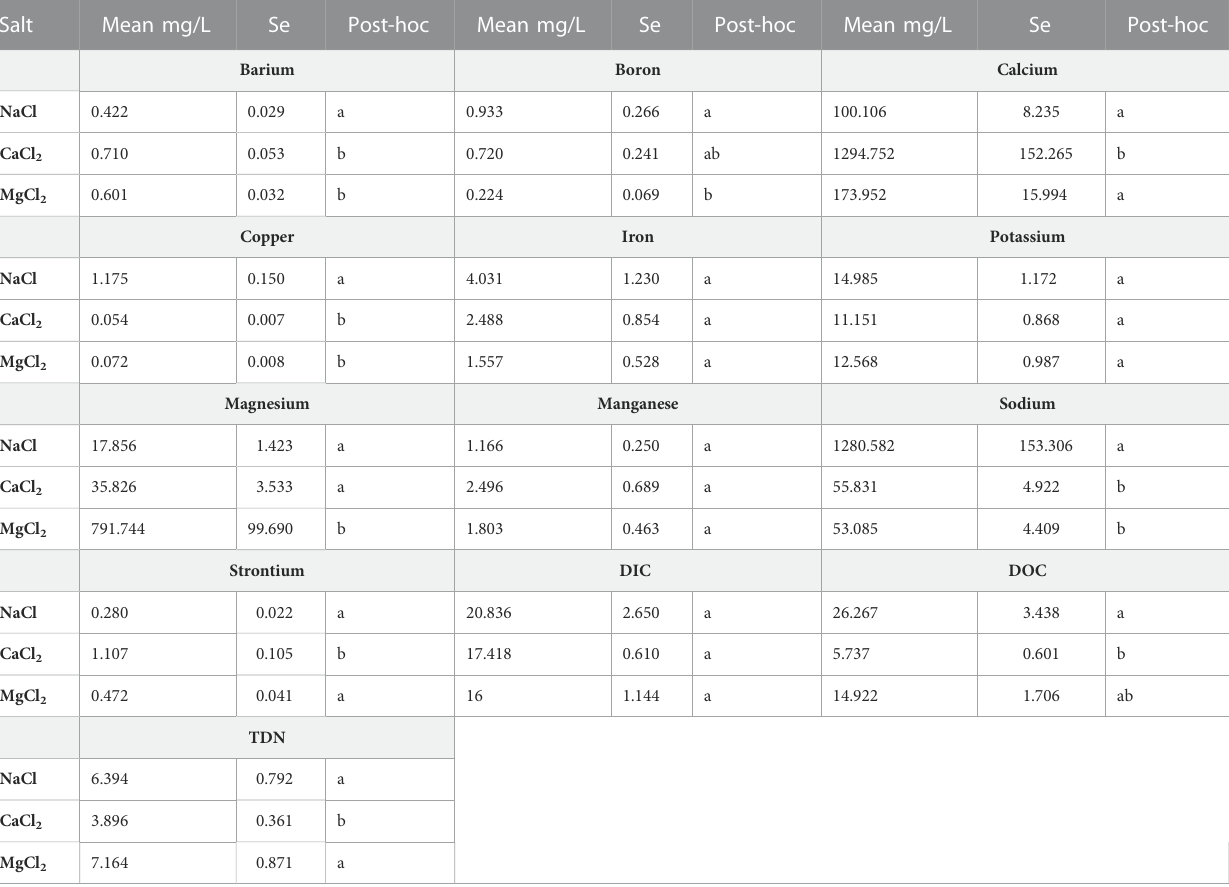
TABLE 4 Tukey ’ s Honestly-Signi fi cant-Difference test was used to compare mean elemental mobilization in the three-way ANOVAs across different salts (NaCl, CaCl 2 , MgCl 2 ). Mean mobilization rates for a given major or trace element share a common letter in the post hoc column when they are not statistically different from one another ( p >